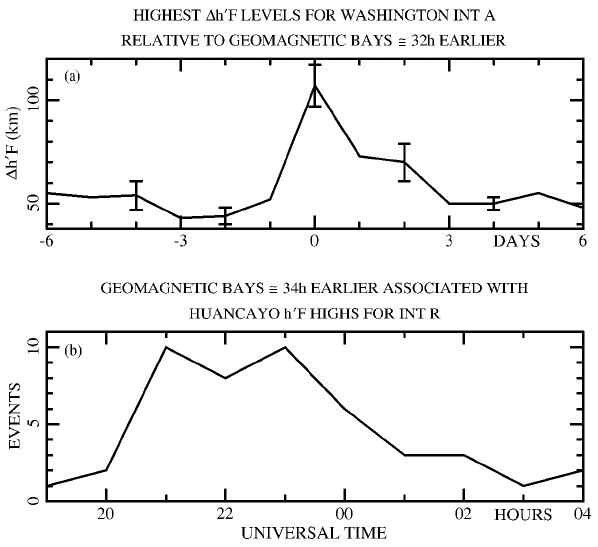
Fig. 9. (a) High Wa 1h 0 F relative to 46 bays on the previous day and (b) the occurrence in UT times of these 46